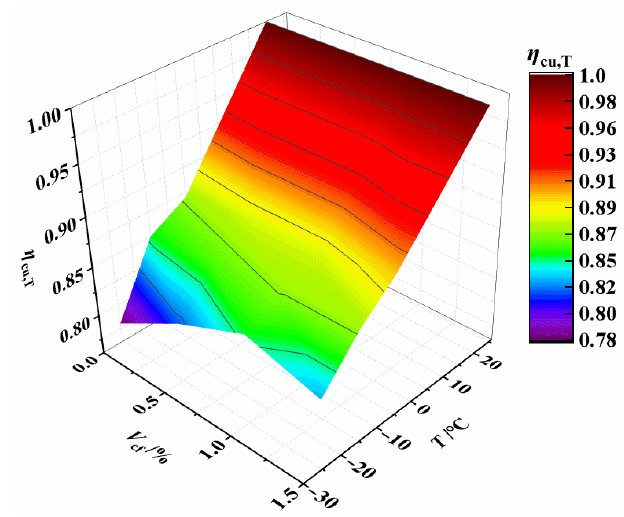
Figure 7. Relationship η cu,T vs. T and V cf.